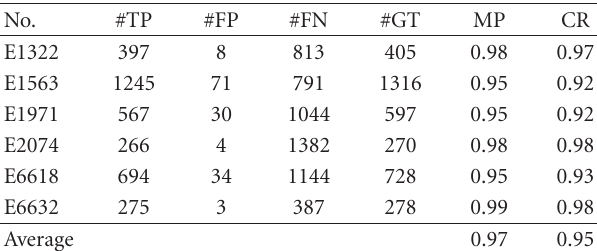
Table 7: The MP and CR value after Bayes-Gaussian